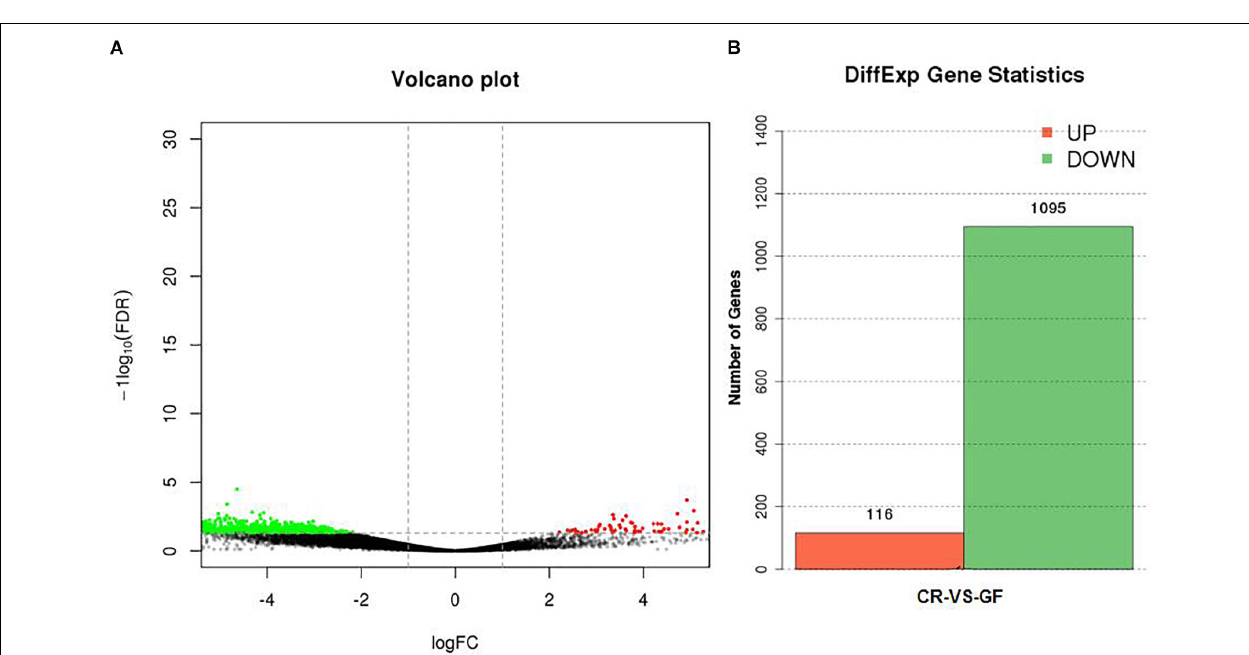
FIGURE 4 | The effect of gut microbiota on the expression level of unigenes in the guts of RPW larvae (A) and the number of genes with significant differences in transcript abundance between CR and GF guts (B) . Green means downregulation, red means upregulation and black means no significance.